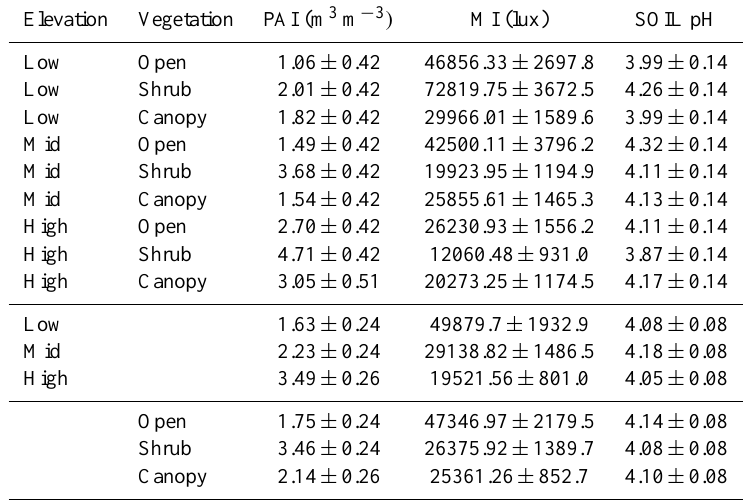
Table A1. Least-squares means of vegetation of PAI (plant area index), midday illuminance (MI), and soil pH. MI is defined as the average of illuminance values recorded at 15min intervals and taken approximately 1m above the ground from 10:00 to 14:00. Error terms indicate standard error.